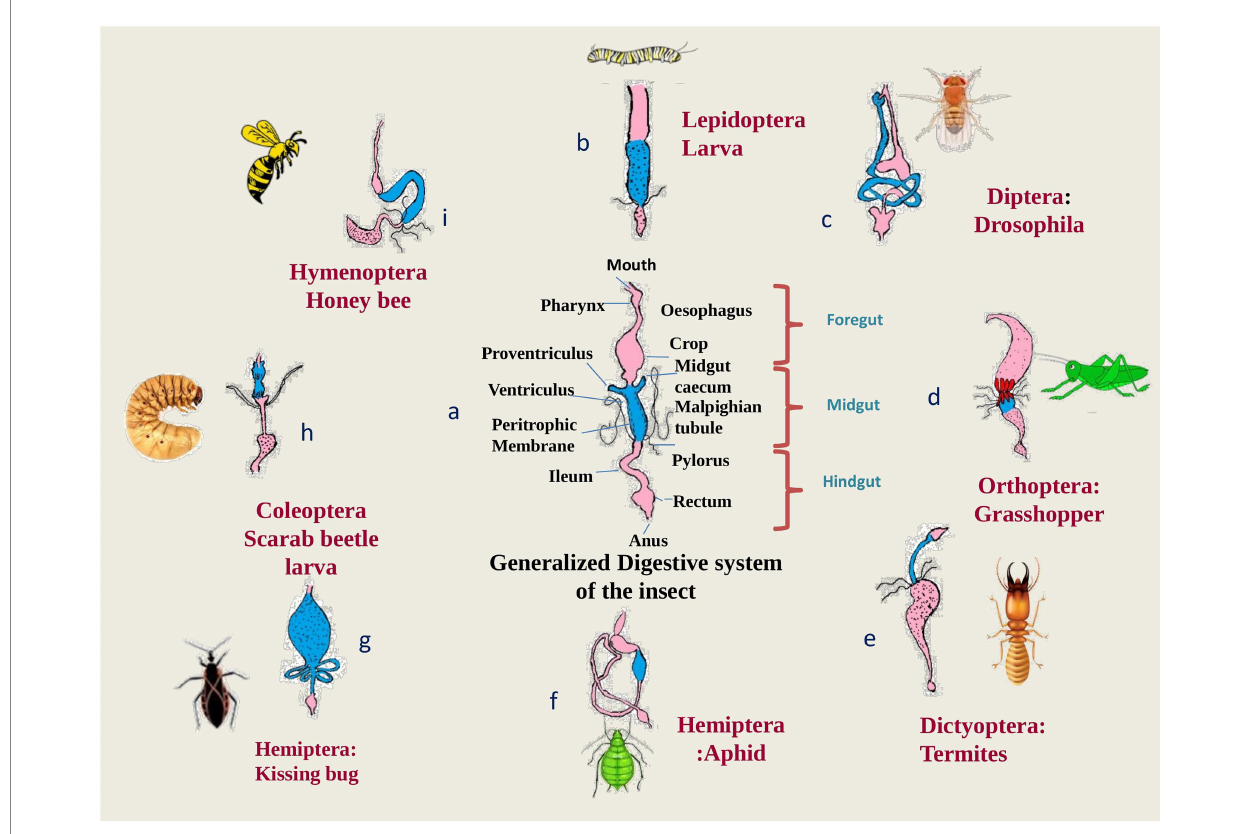
FIGURE 4 Various modifications in the gut structure among the insect orders to accommodate gut symbionts: (A) generalized digestive system of insects with a peritrophic matrix in the midgut (dotted lines). Pink regions indicate the foregut and hindgut, blue regions indicate the midgut. Black dots represented colonies of symbionts; (B) digestive system (D.S.) of a caterpillar of moth showing the presence of symbionts in the region of midgut as well as hindgut; (C) D.S. of Drosophila shows the presence of symbionts in the midgut region only; (D) D.S. of Grasshopper showing the distribution of symbiont in the whole digestive system; (E) D.S. of termites showing symbionts mainly in the hindgut; (F) D.S. of aphid showing the presence of symbionts along the internal lining of hindgut; (G) D.S. of Kissing bug which shows enlarged midgut to store packets of symbionts; (H) D.S. of Scarab beetle larva which shows the presence of symbionts in the hindgut; (I) D.S. of honey bee showing the presence of symbionts in hindgut region (Buchner, 1965; Chapman, 1998; Fukatsu and Hosokawa, 2002; Brune, 2010).